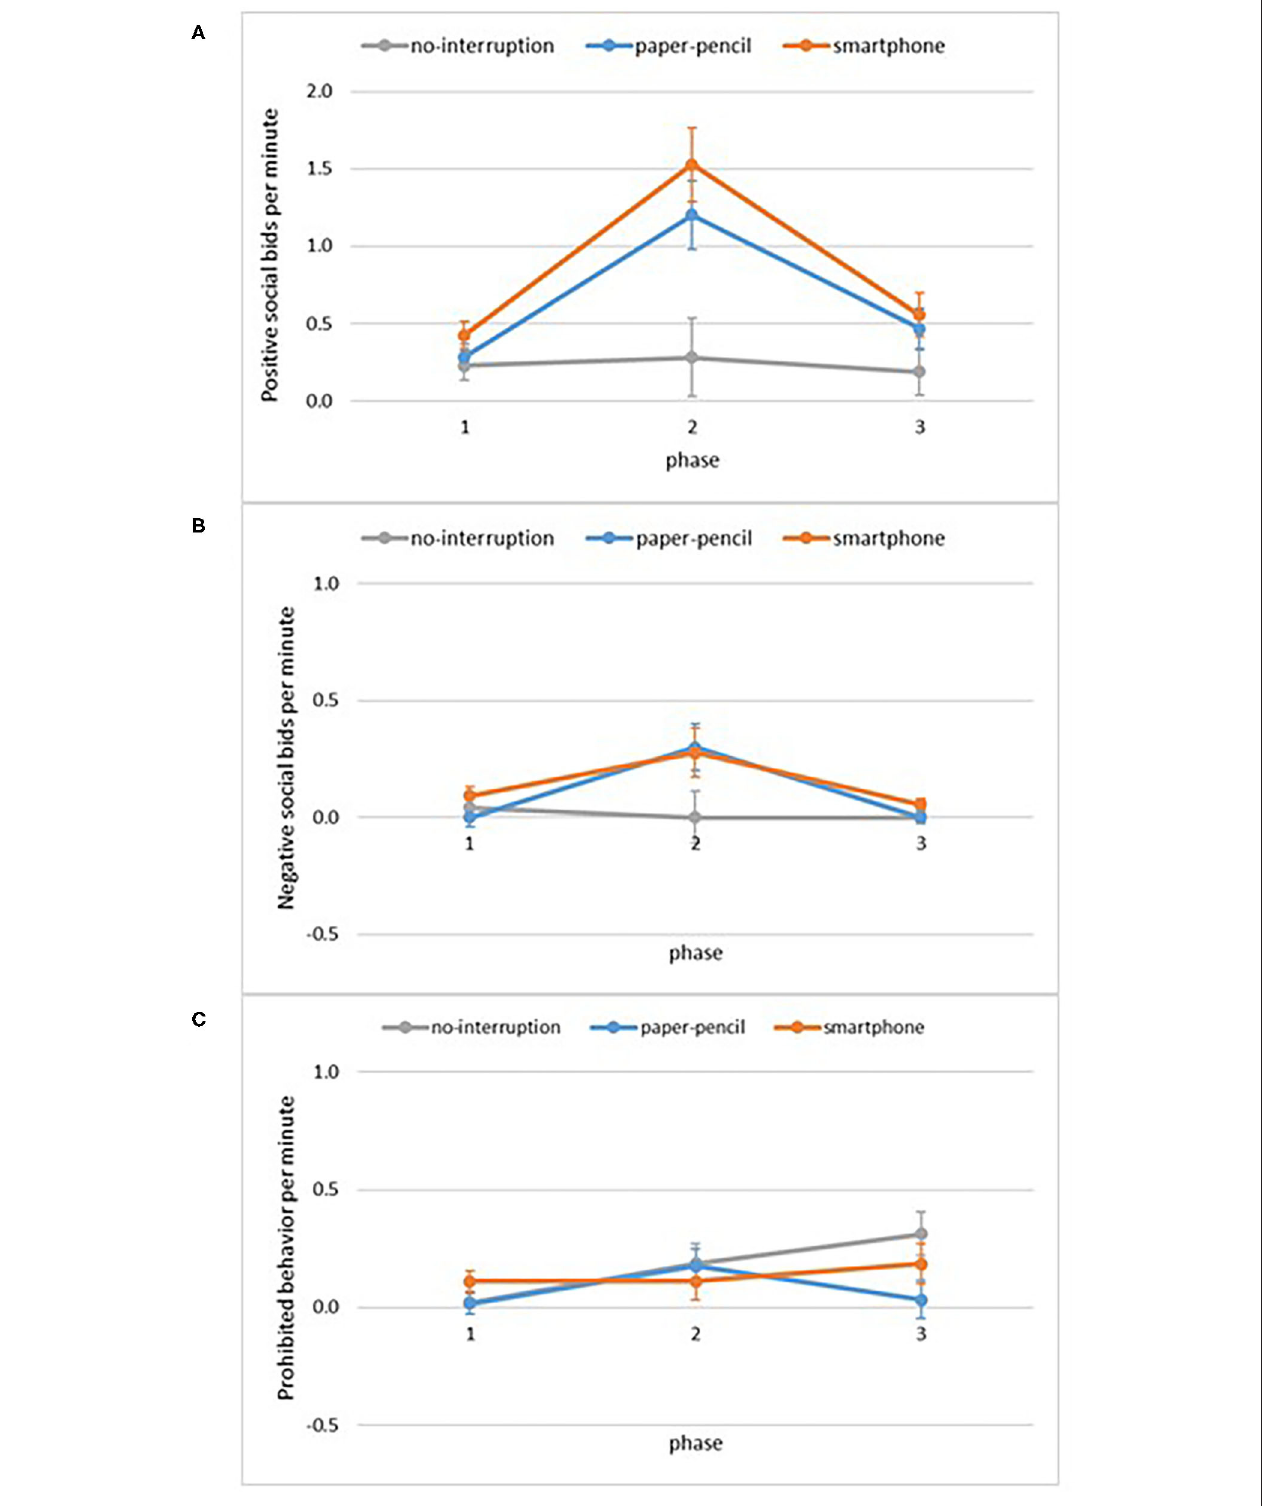
FIGURE 3 | Child behaviors per minute as a function of phase and condition. (A) Positive social bids per minute, (B) negative social bids per minute, (C) prohibited behavior per minute. Error bars are SE of M.